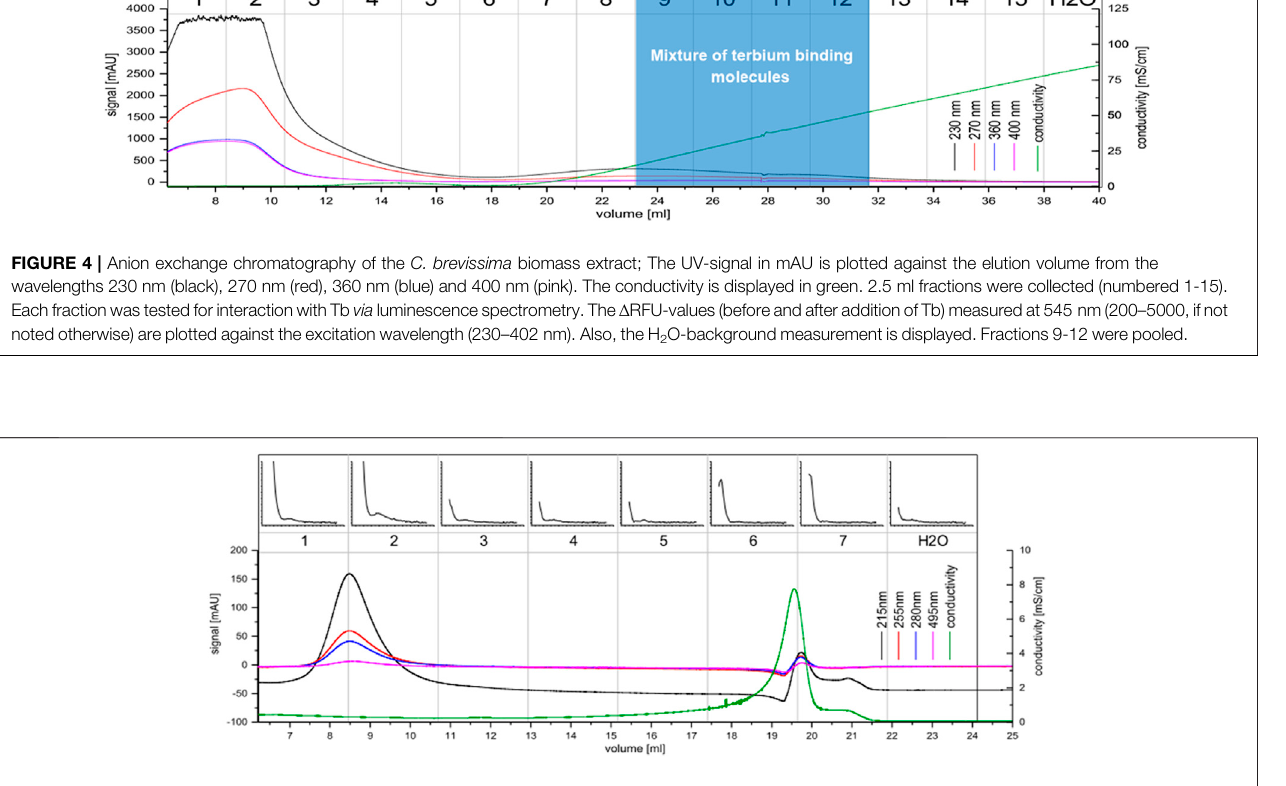
up to a pH of 9.5 (see Figure 7 ) when the isolated fractions were added. This indicates that the chelates are stable even at high pH values. Moreover, the applied Eu 3+ concentration was above the